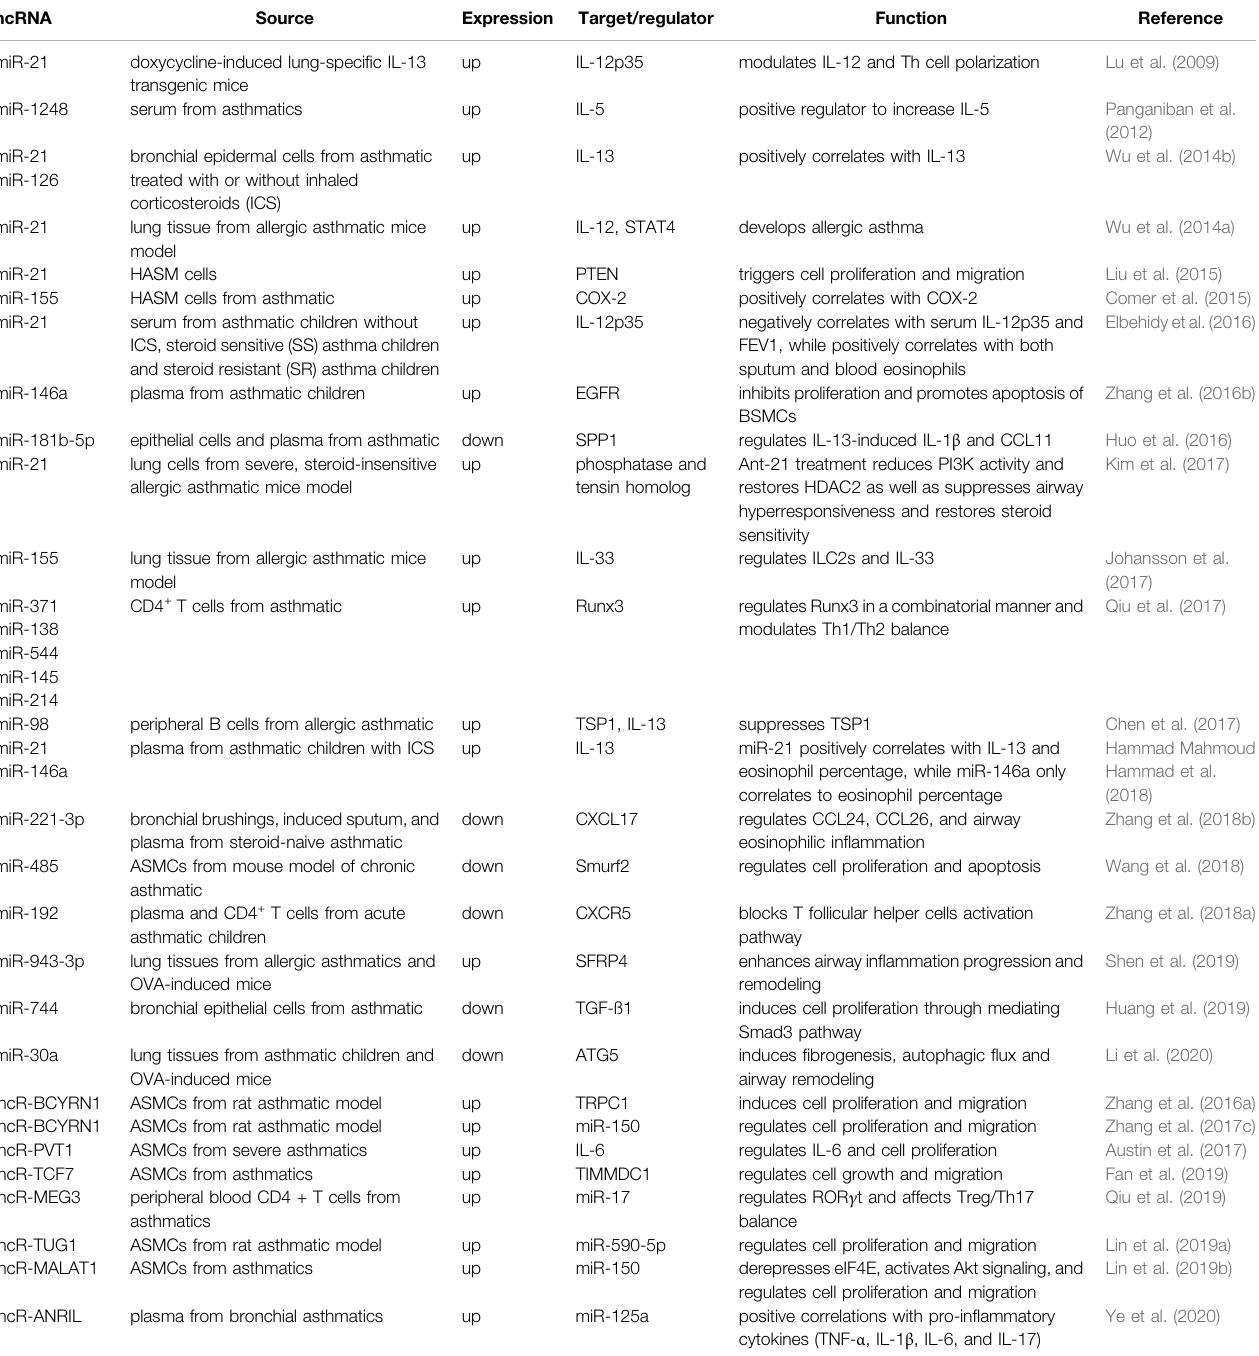
TABLE 1 | List of ncRNAs and their targets and functions in